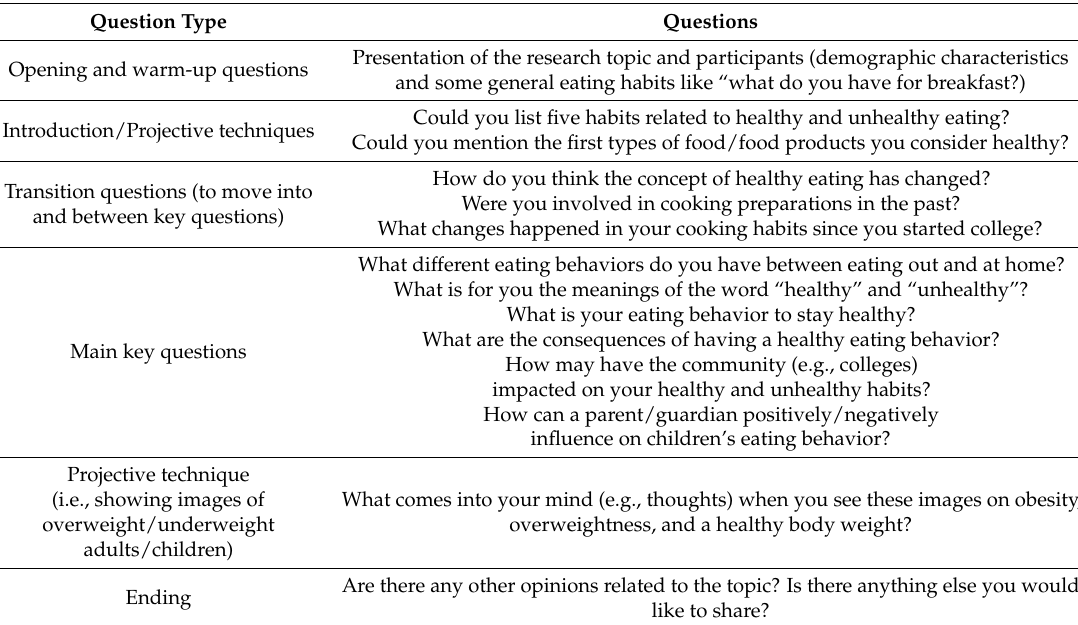
Table 1. Short version of the Focus Group questions